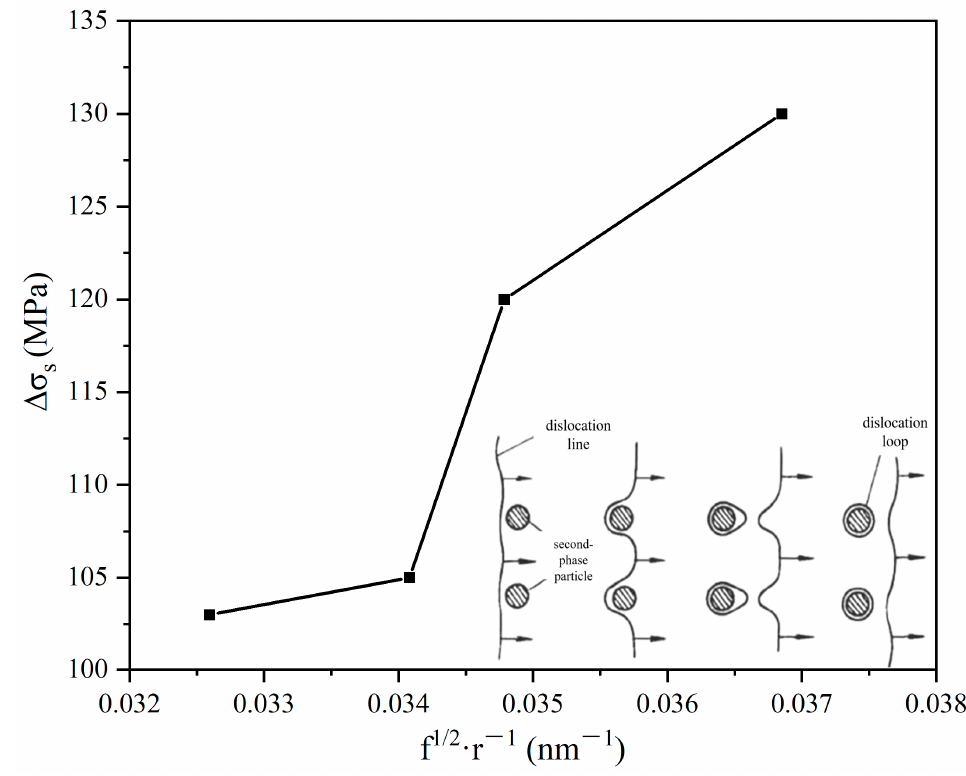
Figure 13. The variation tendency of yield strength increments with the f 1/2 · r － 1 . Figure 14 shows the fracture surfaces of the alloys after T6 treatment. The casting defect does not be observed in the fracture surfaces. The fracture surfaces of the four alloys are occupied by dimples formed by spheroidizing and dispersive Si particles. These dispersive Si particles can result in the fine and homogeneous dimples during one-axis loading process, which is important for high ductility of Al-Si-Mg-Cu cast alloy. In the loading-bearing process, most granular Si particles were pulled out in dimples, and dimples formed in the Al matrix, represented by the yellow arrows in Figure 14. Moreover, the fracture surfaces in T6-treated samples do not show the residual Cu- and Fe-containing phases, avoiding adverse effect on the ductility by coarse intermetallic. Therefore, the elongations of aging-treated samples are higher than 8%, which can meet the engineering application requirements of Al-Si-Cu-Mg casting